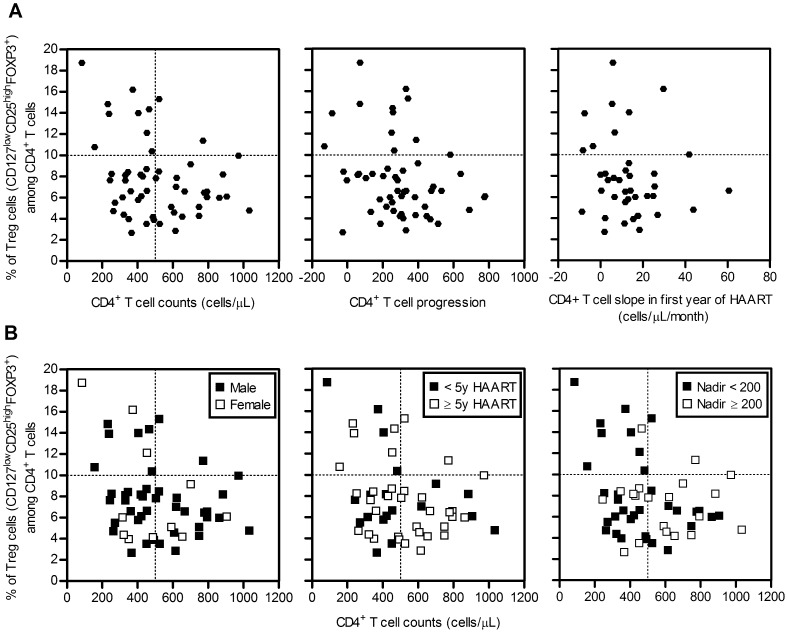
HIV+ individuals with high Tregs percentages feature low CD4+ T cell counts and Nadir values.
A. Percentages of Tregs amongst HIV+ individuals were plotted against CD4+ T cell counts, CD4+ T cell progression and CD4+ T cell slope (for the first year of HAART). Each dot represents a single individual. B. Tregs percentages were plotted against CD4+ T cell counts in HIV+ individuals grouped by gender) number of years under HAART and the Nadir value.